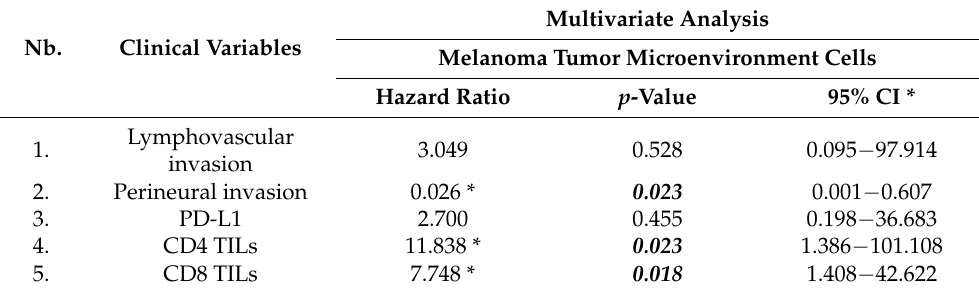
Table 4. Logistic regression of potential prognostic values of PD-L1, CD4, and CD8 TILs in melanoma